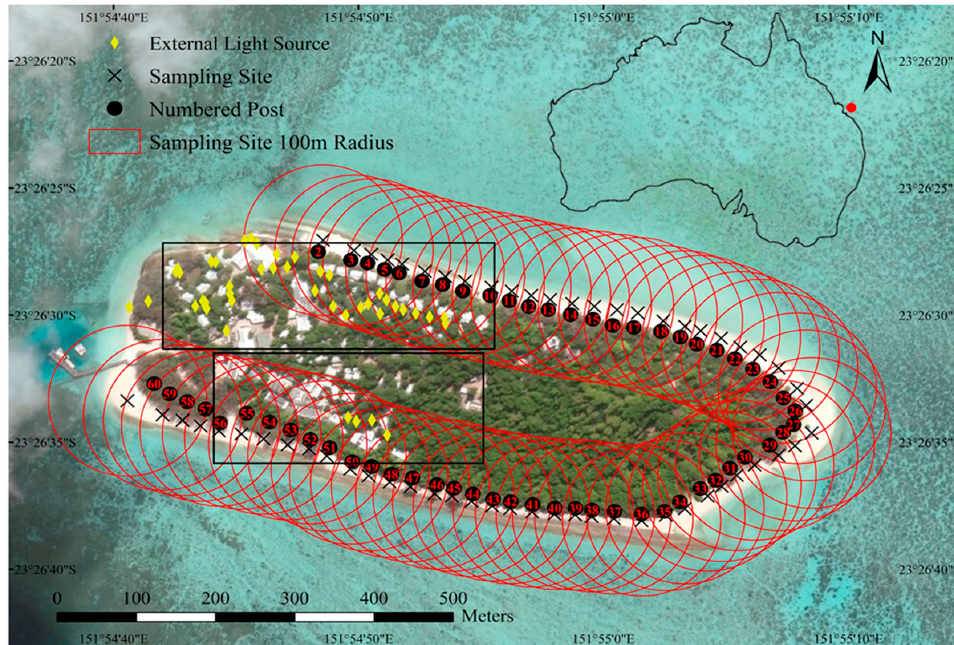
Figure 1. Satellite image of Heron Island showing the locations of the 59 sampling sites (black crosses), the corresponding 100 metre radius around each site (red circles), and the external lighting sources (yellow diamonds). The University of Queensland Research Station buildings in the south-west are shown in the bottom black rectangle and the Heron Island Resort buildings in the north-west are shown in the top black rectangle. Inset map shows Heron Island’s location (red dot) relative to mainland Australia.